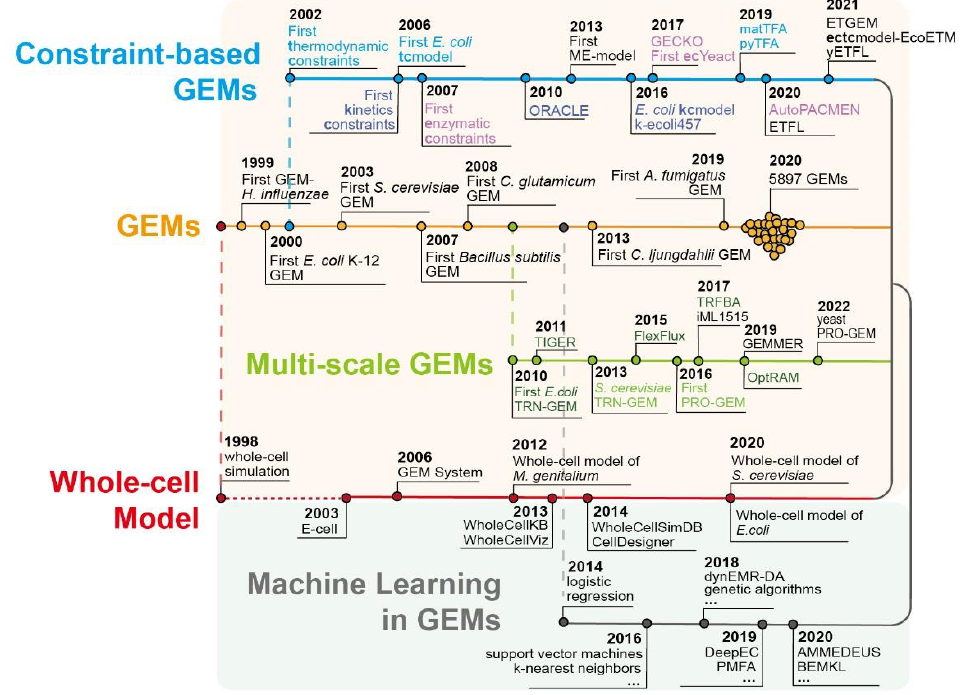
Figure 1. The main development timeline of multiscale GEMs and the application of machine learning.